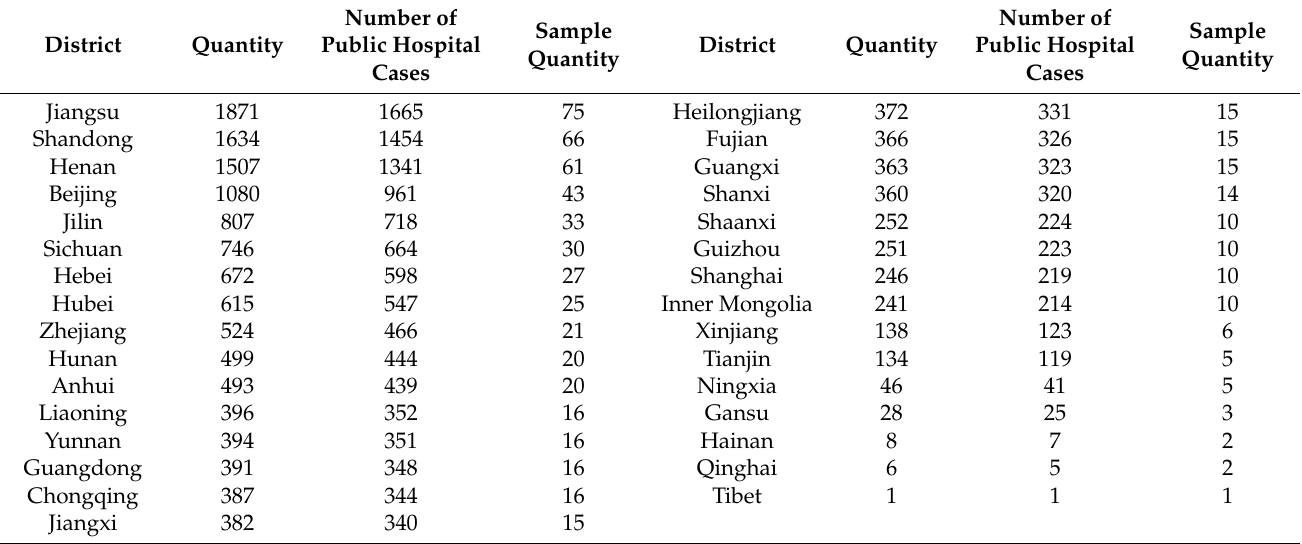
Table 1. Summary of doctor–patient disputes data in various provinces in